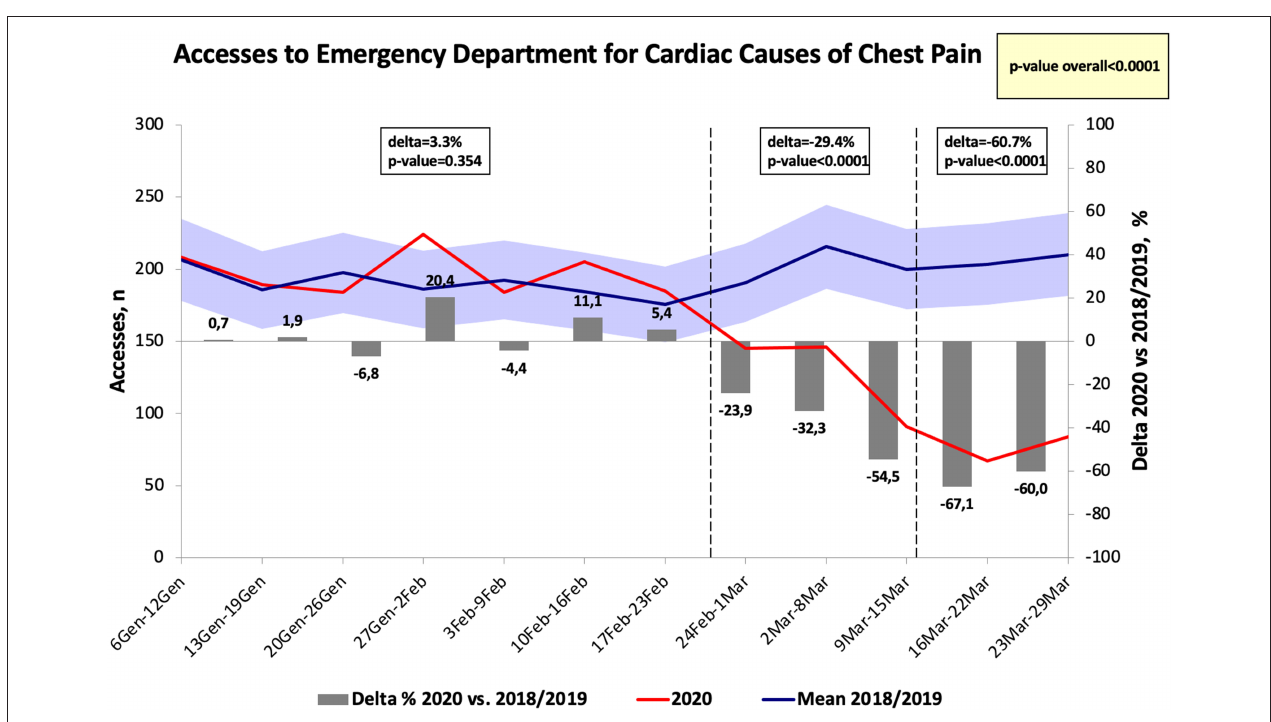
FIGURE 3 | Number of accesses to emergency department for cardiac causes of chest pain in Tuscany.